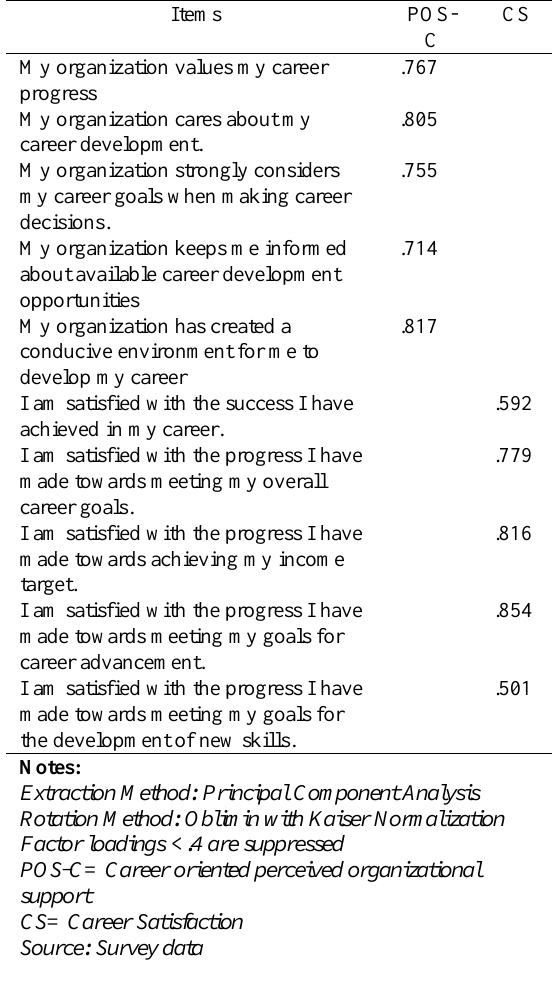
Table 2: Rotated Factor Loading